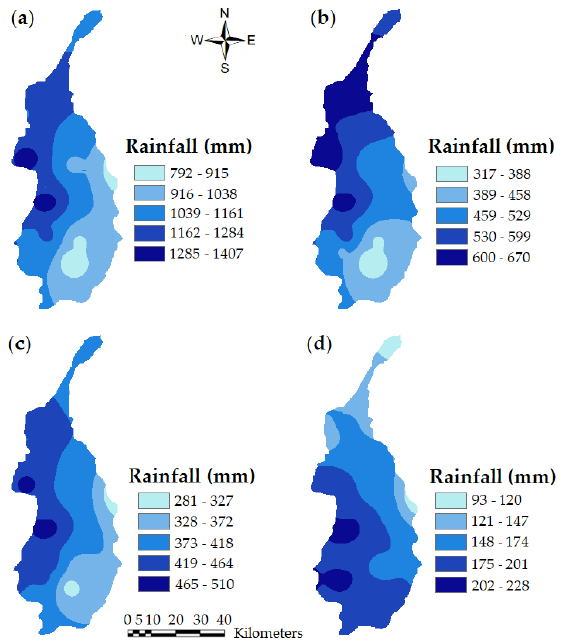
Figure 3. Spatial distribution of annual and seasonal mean rainfall (mm) for the period 1986–2015: for ( a ) the annual, ( b ) the Kiremt, ( c ) the Belg, and ( d ) the Bega seasons.